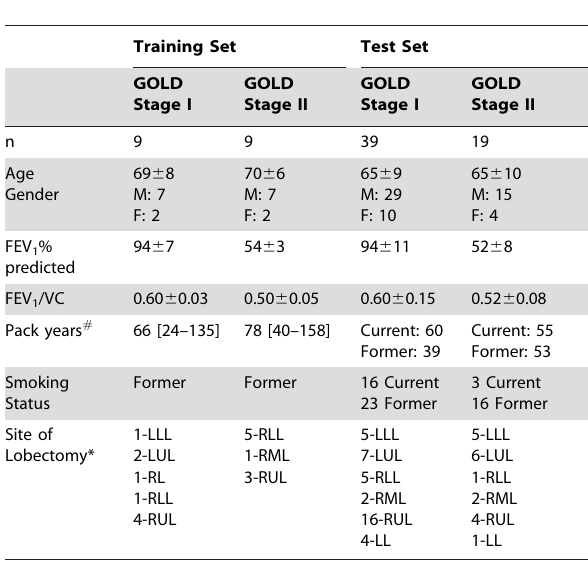
Table 1. Demographics of COPD patients in the TPCH training and test